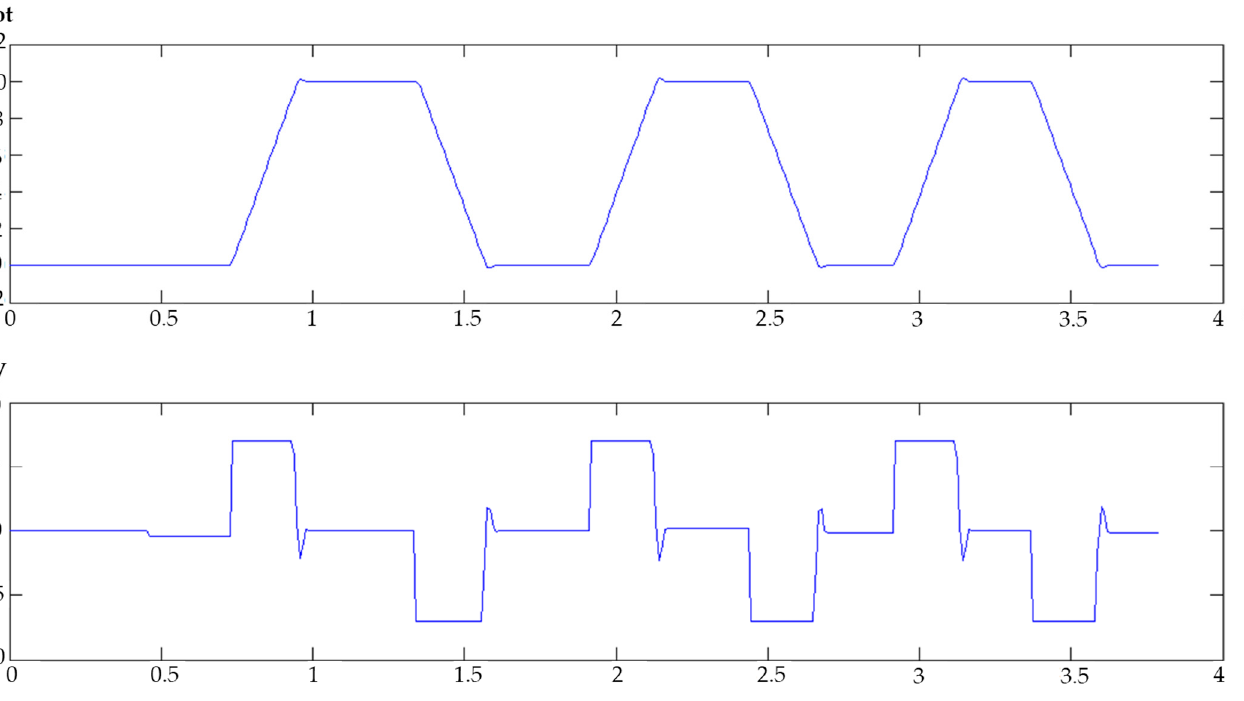
Figure 7. Real motor positioning.